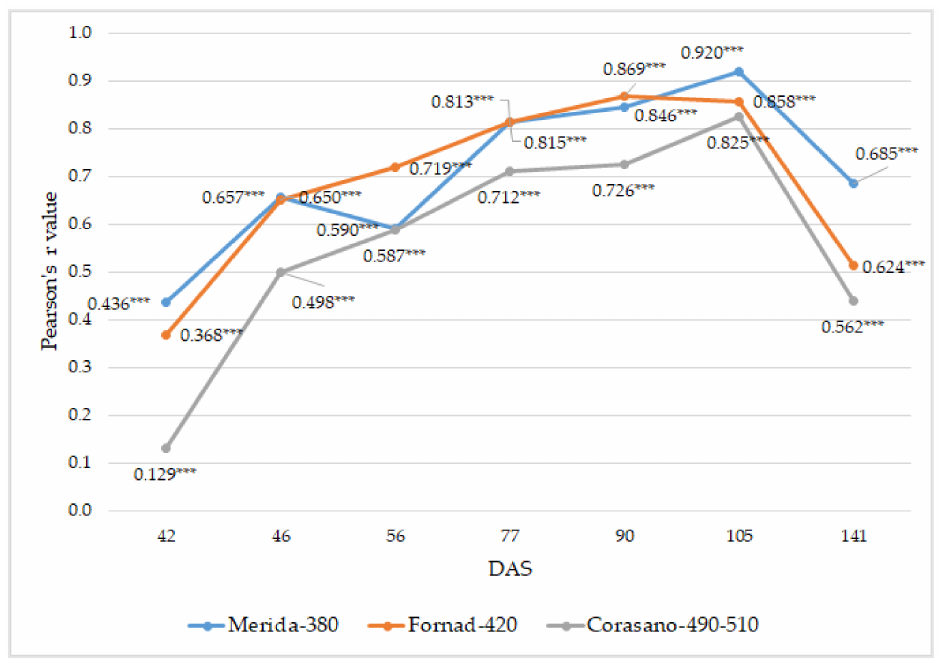
Figure 11. Pearson correlation coefficient (r) dynamics among NDVI UAV and yield t ha − 1 as a result of different hybrids (2021, Debrecen). Note: ***. Correlation is significant at the 0.001 level.